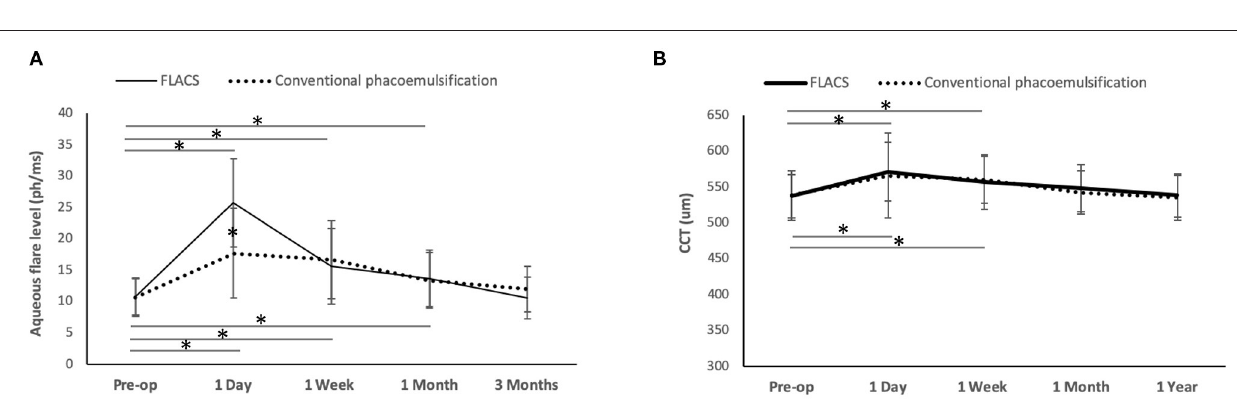
( P = 0.47), for the FLACS and conventional procedures, respectively. For the FLACS group, the mean pupil area significantly reduced after laser pre-treatment, from 40.5 ±